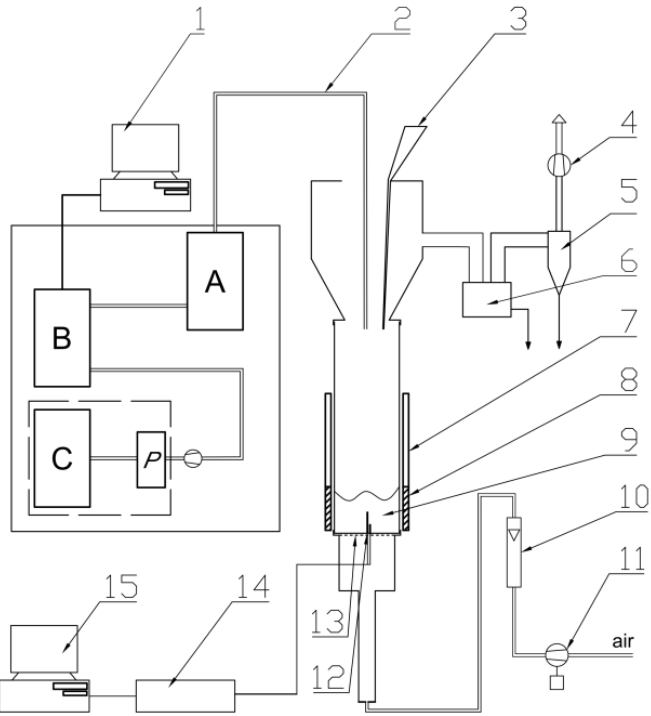
Figure 1. Scheme of the fluidized bed reactor: 1 — computer connected with the FTIR analyzer; 2 — heated probes for sampling the flue gases; 3 — batcher; 4 — exhaust fan; 5 — cyclone; 6 — ash trap